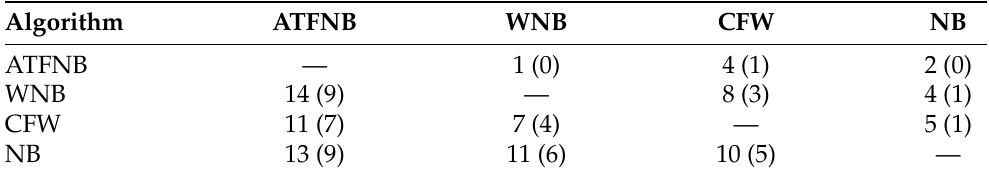
Table 10. Summary two-tailed t -test results of classification accuracy with regard to ATFNB on Flavia dataset.